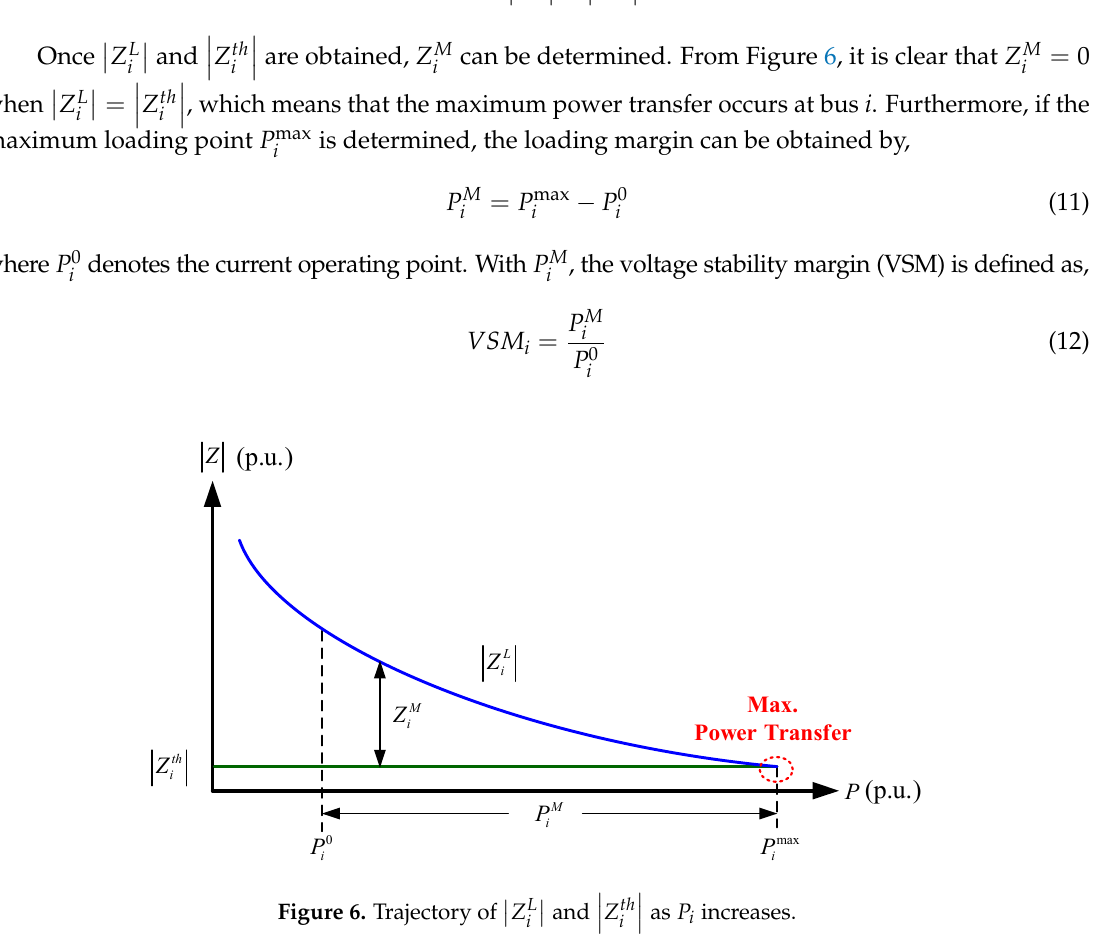
Figure 6. Trajectory of